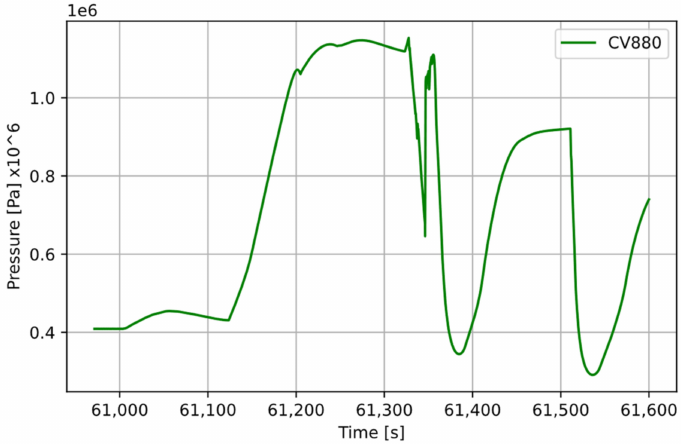
Figure 12. Water coolant pressure in the liner cooling loop water pipes after